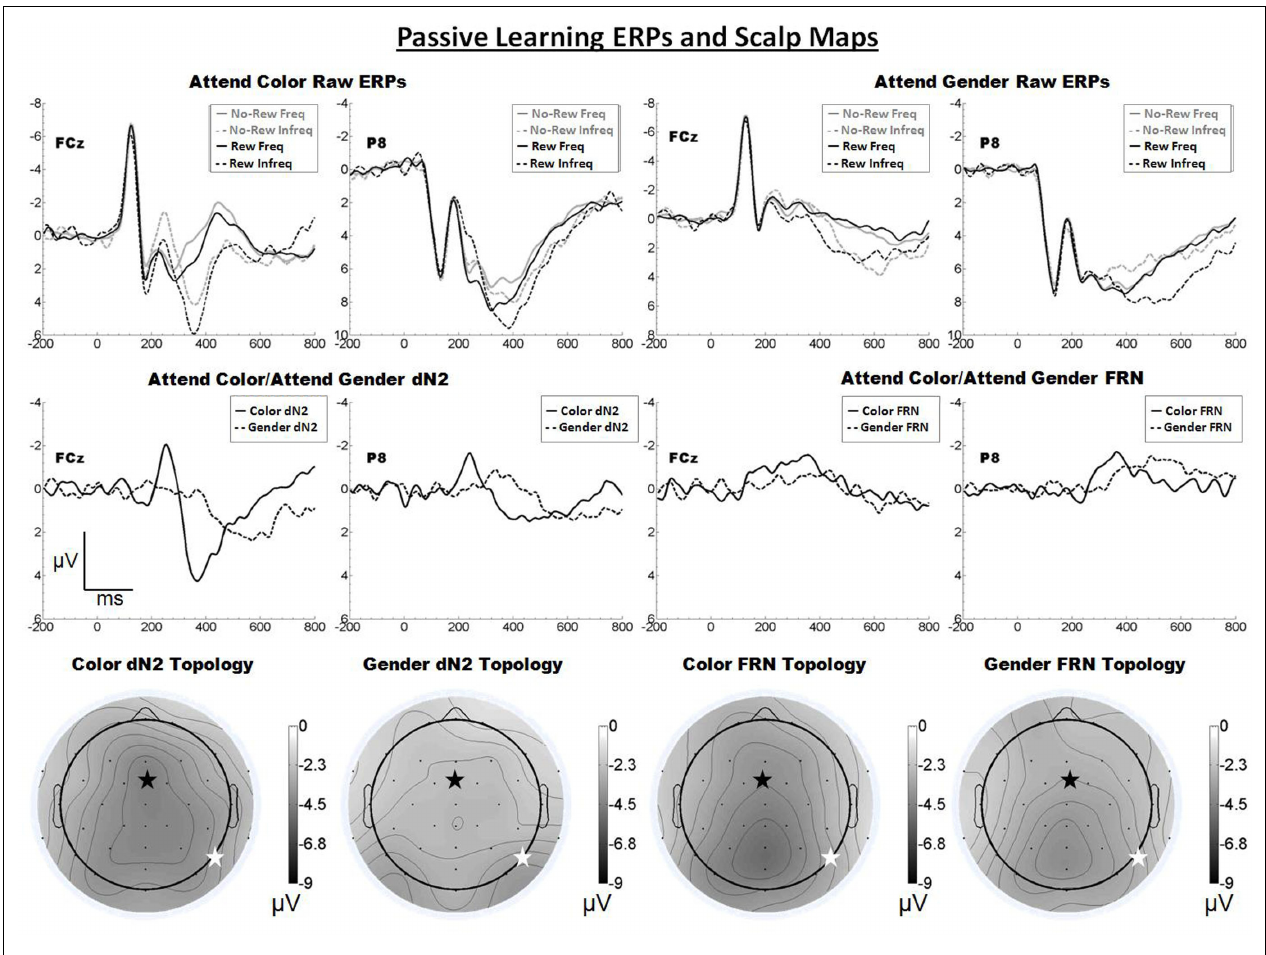
electrodes.The bottom row shows the scalp distributions of the dN2 and FRN across tasks.The scalp distributions reflect the base-to-peak measure of each of the dN2 and FRN.The black star on the scalp map denotes channel FCz, and the white star denotes P8. Note that negative is plotted